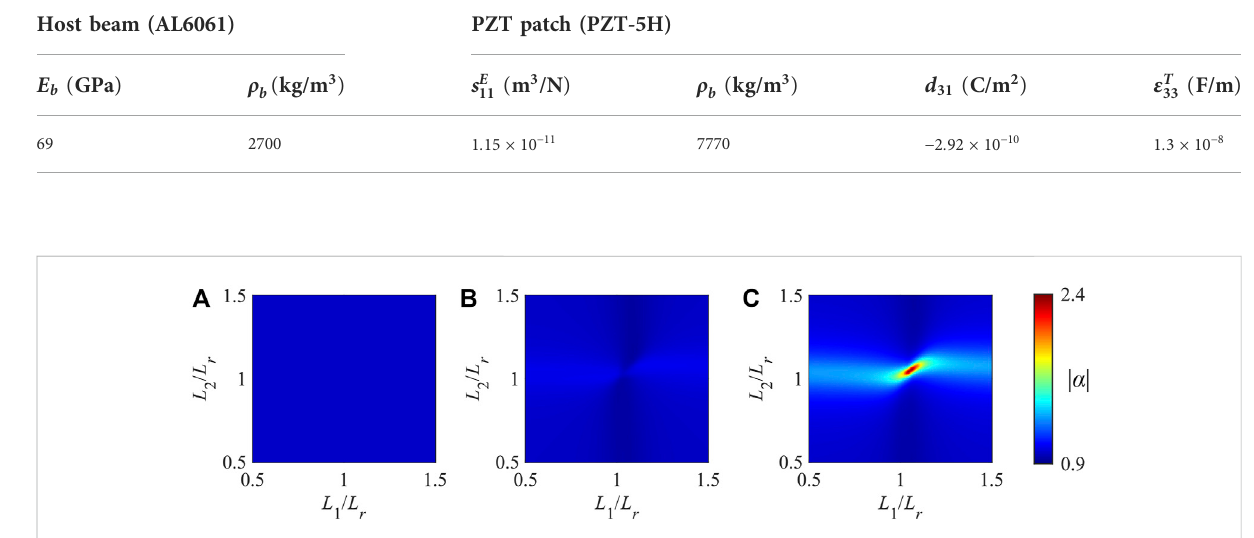
L (A) case 1: R 1 and 2 at